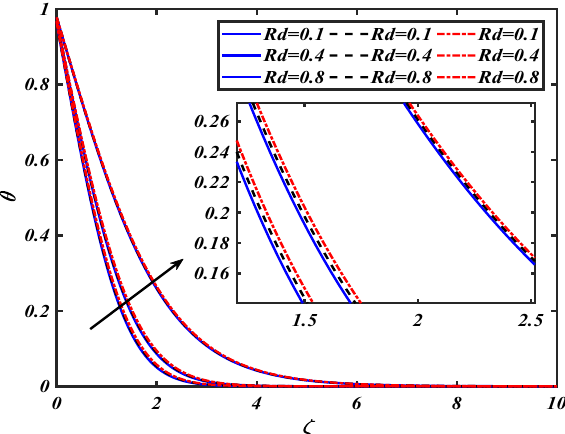
Figure 14. Pictogram of Rd via θ .